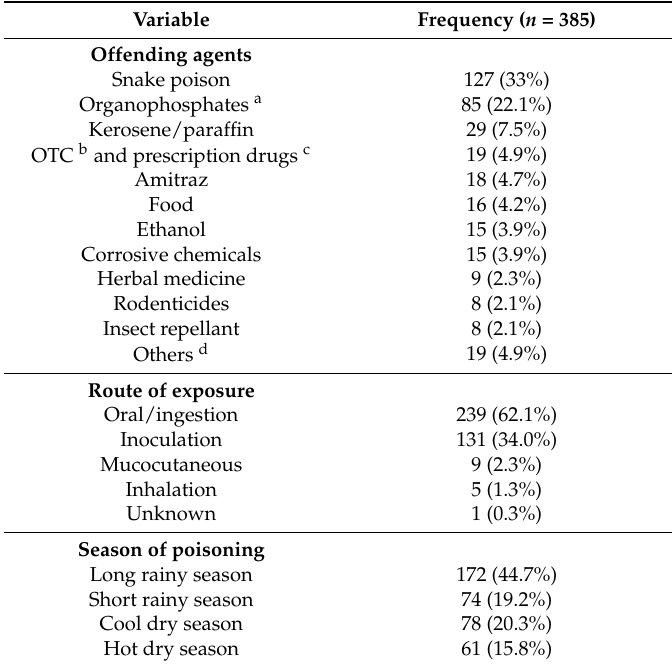
Table 3. Offending agents, routes of exposure and season of